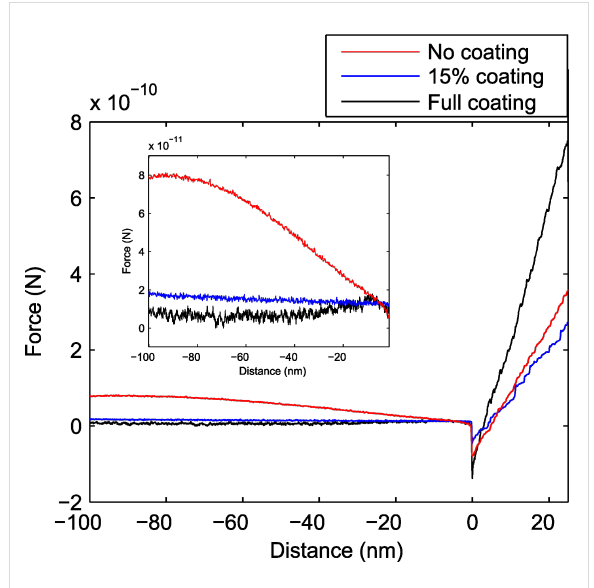
Figure 4: Force–distance curves for an uncoated (red), partial coated (blue) and fully coated soft cantilever (black) with a measurement bandwidth of 1 kHz. In the inset, the approach region is plotted for better illustration of the noise. One can see that the fully coated cantilever shows the highest noise. The uncoated cantilever shows largest variation of the force before contact which is due to the optical interference of the detection laser